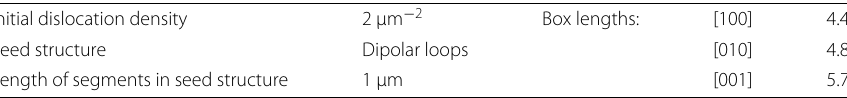
Table 1 Initial configuration